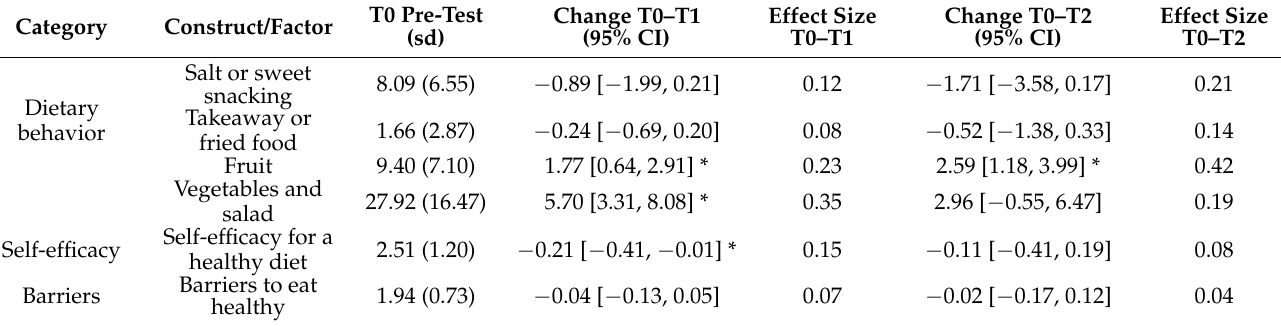
Table 4. Results of the subjective measurements regarding dietary behavior.